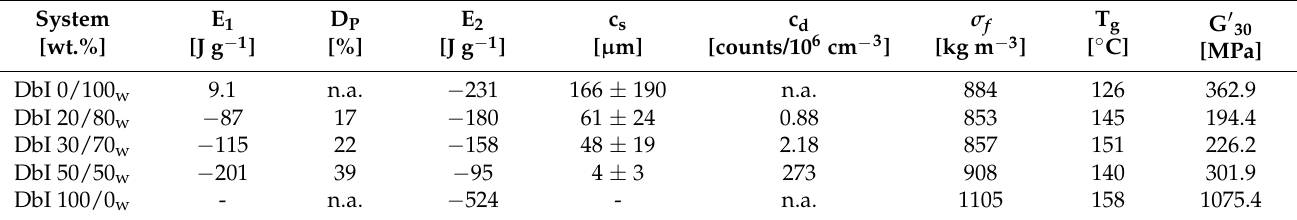
Table 2. (Pre-)curing peak energies (E 1 and E 2 ) and resulting pre-curing degree (D P ), as well as foam properties with regard to cell size (c s ), cell distribution (c d ), foam density ( 𝜎 (cid:3033) ) (process adjusted density is 860 kg m − 3 ) and T g (loss modulus G ″ max. in DMA) as well as the storage modulus (G ′ ) received at 30 °C from DMA (G ′ 30 ) of the different blend systems.